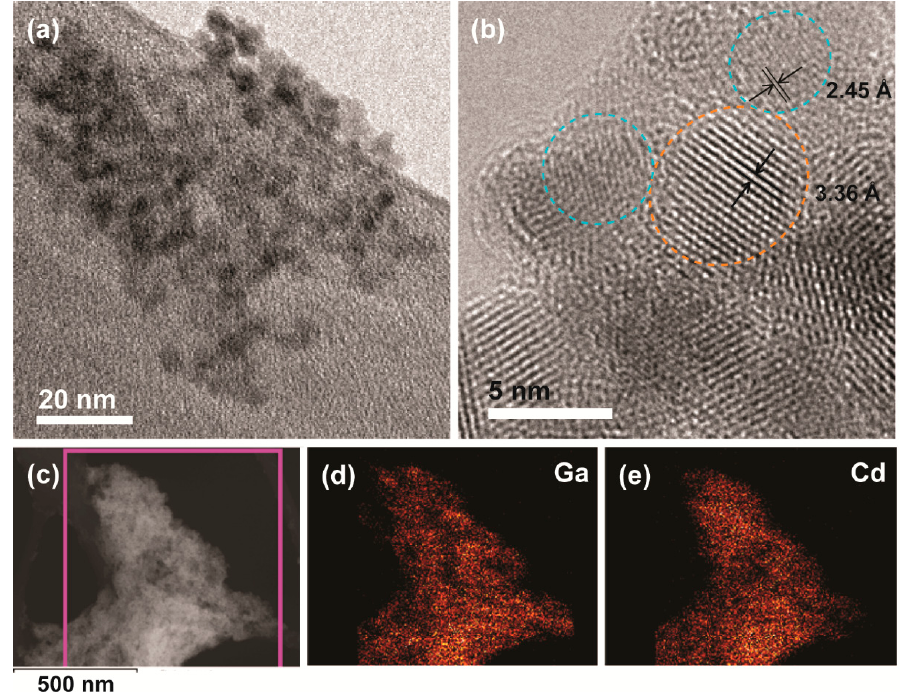
Figure 2. ( a ) Overview TEM image of colloidal Ga 2 O 3 -CdSe/CdS NC conjugate obtained using NCs shown in Figure 1; ( b ) High resolution TEM image of the same sample. Orange and blue circles indicate CdSe/CdS and Ga 2 O 3 NCs, respectively; the lattice spacings shown correspond to {002} and {311} planes of CdS and Ga 2 O 3 , respectively; ( c – e ) Scanning transmission electron microscopy (STEM) image of the nanocrystal conjugate ( c ); and the corresponding Ga ( d ) and Cd ( e ) energy-dispersive X-ray spectroscopy (EDX) elemental maps.